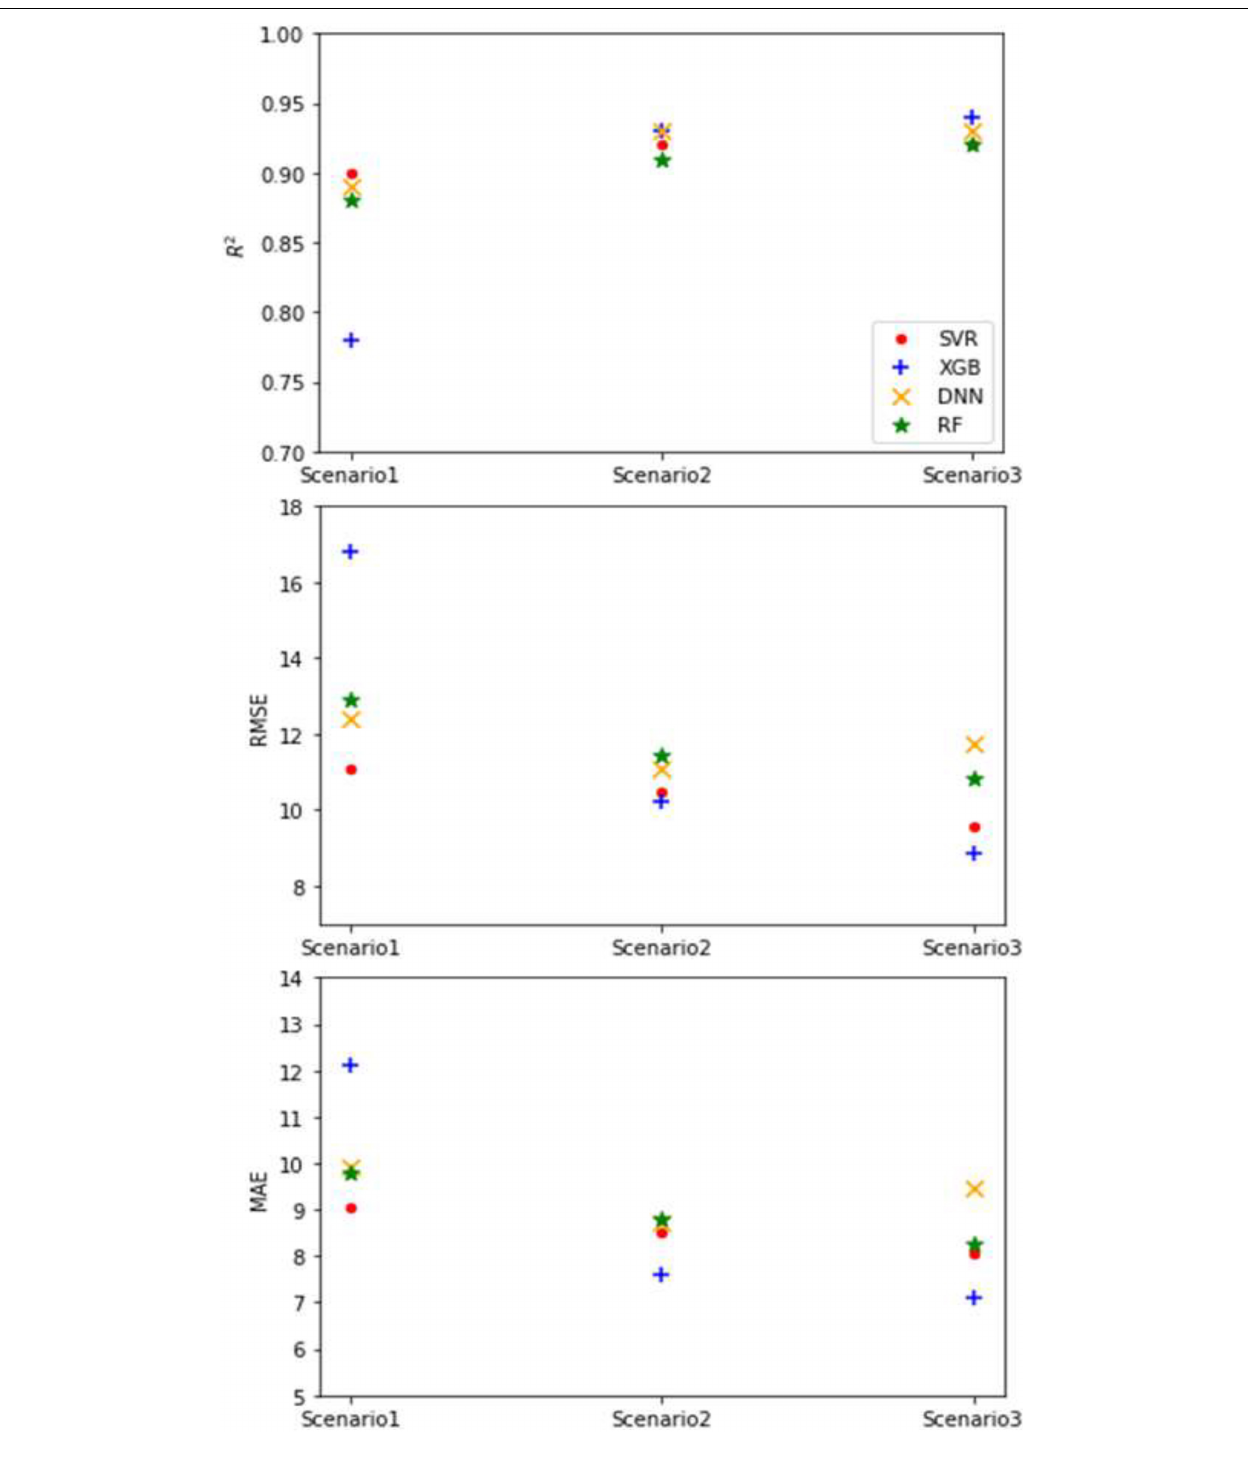
max depth (1, 2, 5, 10, and 12); and learning rate (0.05, 0.1, and 0.5). RF was trained using 400 trees, where 10 max depth and the default values of the other hyperparameters were